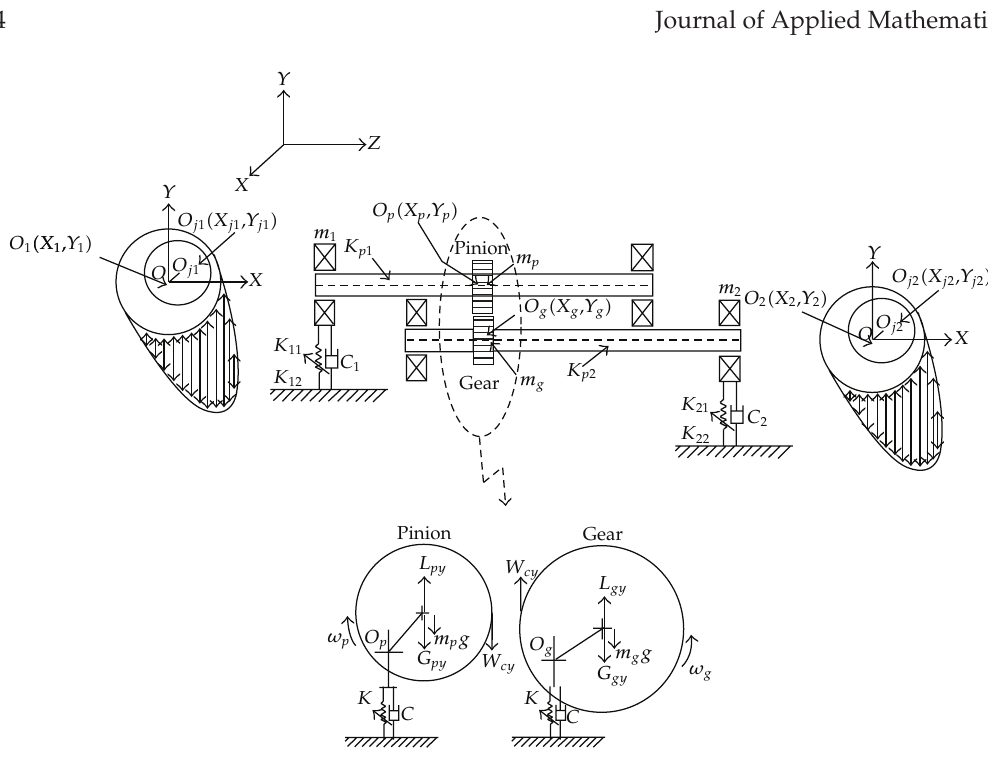
Figure 1: Schematic illustration of the gear-bearing system under nonlinear suspension and the model of force diagram for pinion and